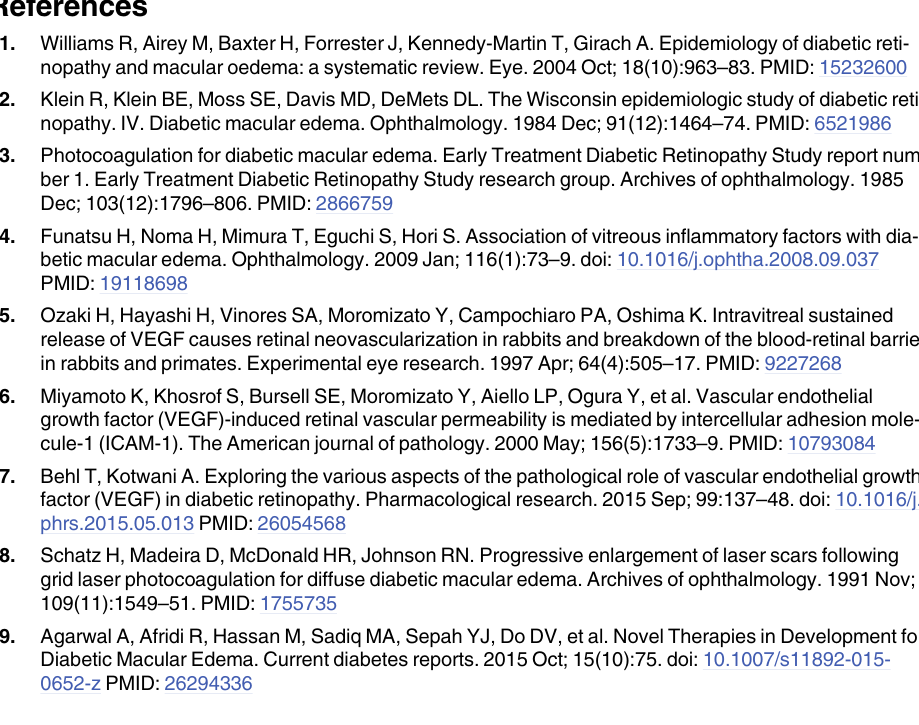
S1 Table. Node-splitting and pair-wise meta-analysis. S2 Table. Ranking based on simulations. S3 Table. Sensitivity analysis for included studies of